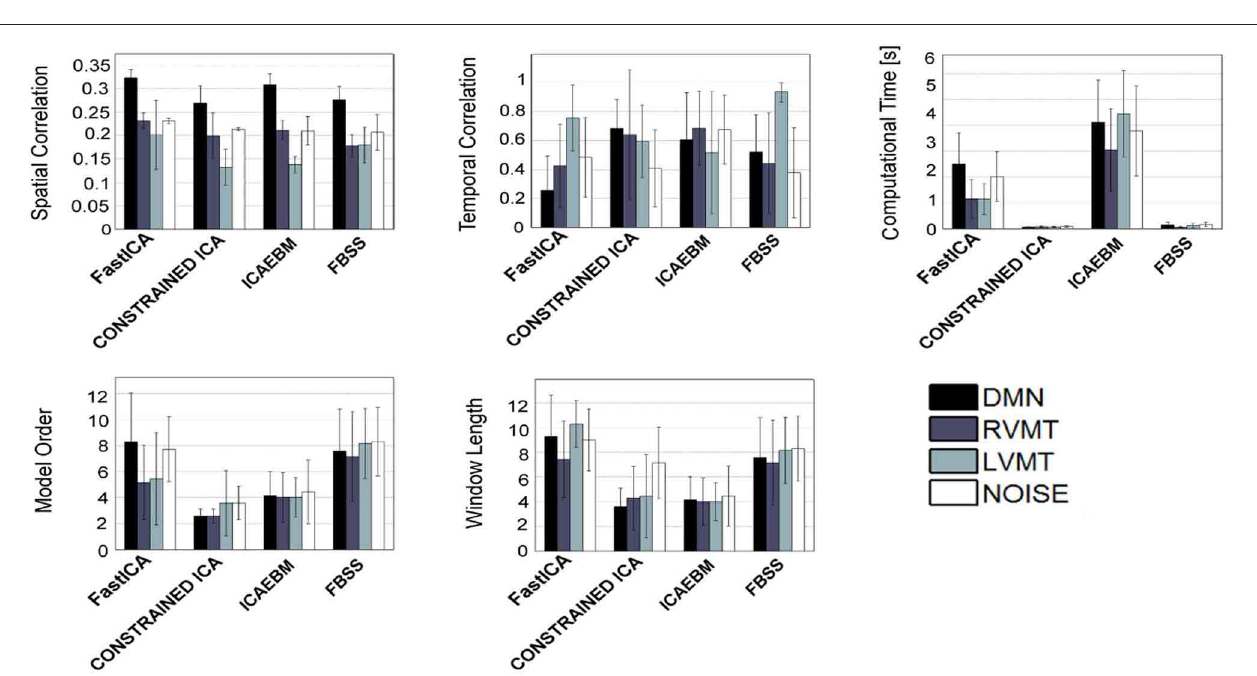
FIGURE 4 | Results of the best performing runs (mean across subjects) for all available ICA algorithms for a growing length of time window up to 12 TRs and no a priori information considered. For each ICA algorithm the values of similarity (Sim), computational time (CT), temporal correlation (TC), model order (MO), and window length (WL) w.r.t. four reference ICs representing brain activities of interest ( Figure 3 ), are reported for the